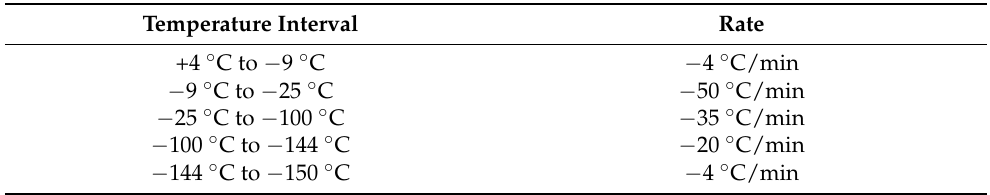
Table 1. The freezing protocol set on a programmable freezing machine (SYLAB Gerate GmbH, Neupurkersdorf,